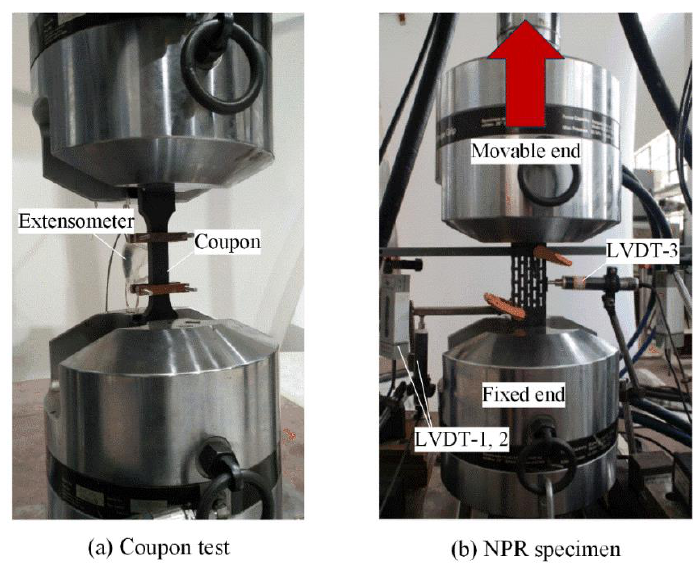
Figure 3. MTS machine and setting of test pieces with (a) Coupon test and (b) NPR specimen.